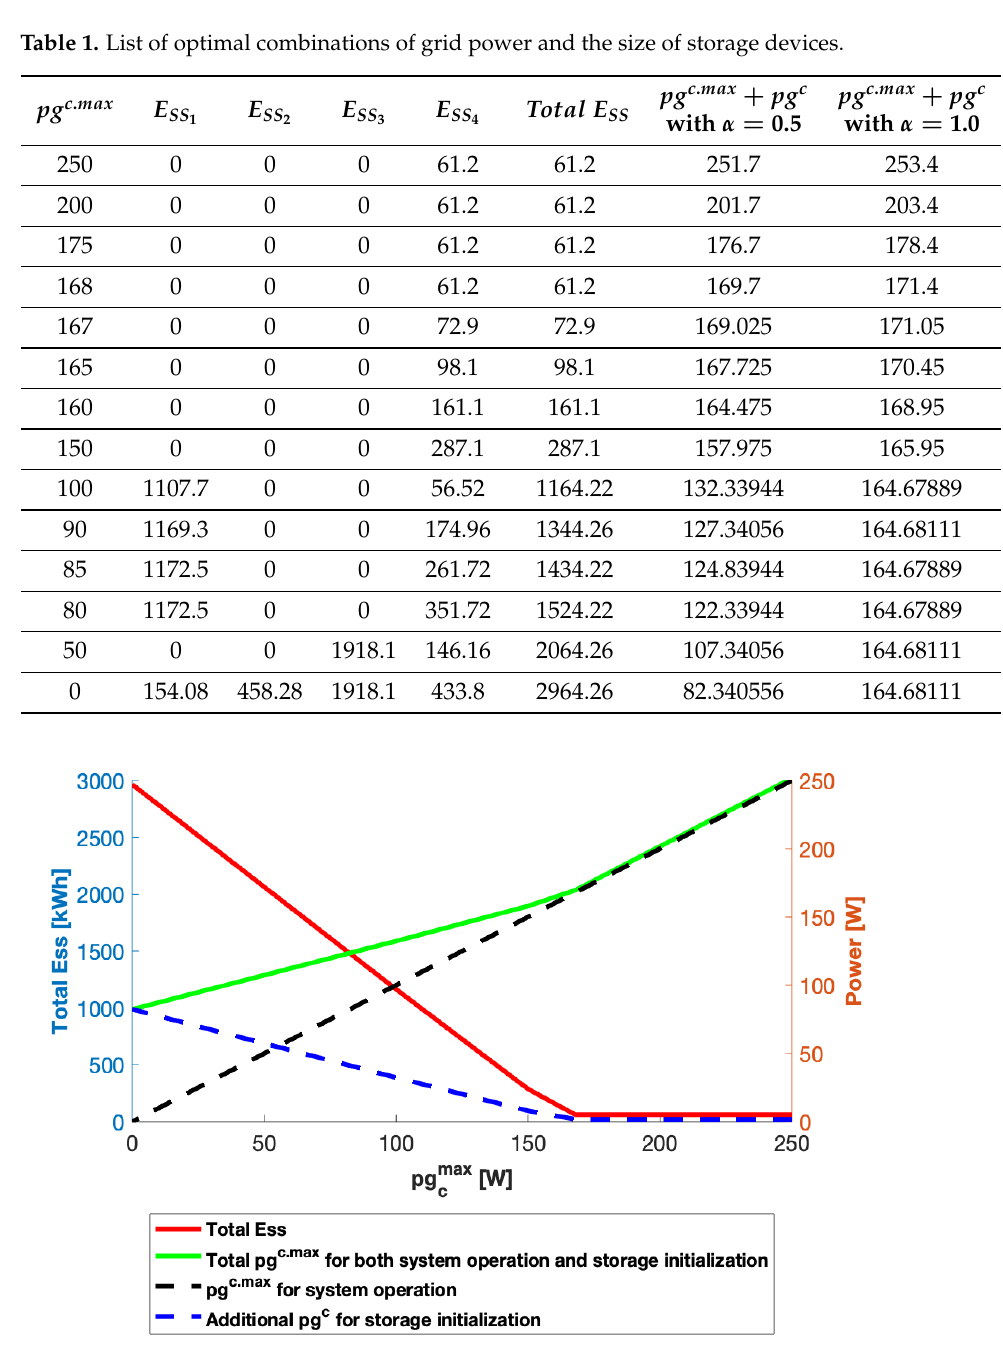
Figure 20. Power storage device capacity vs. power grid for the case α =